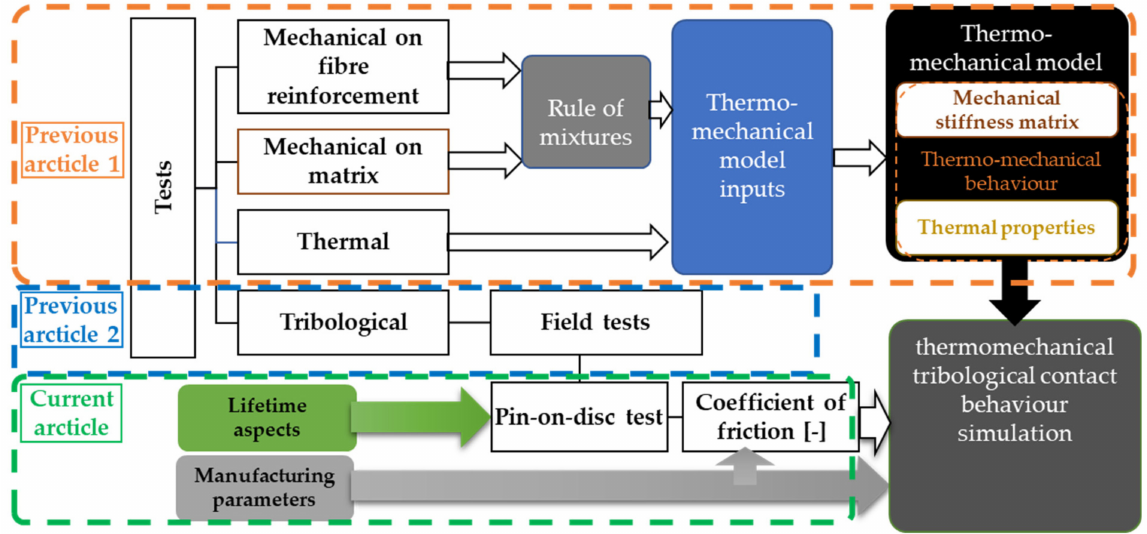
Figure 1. Thermomechanical characterization and modeling method with tribological aspects.